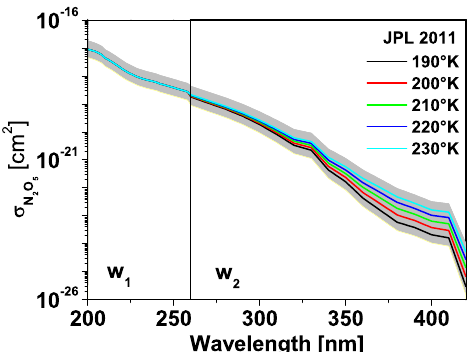
(λ,T ) Figure 2. Absorption cross section and uncertainty of σ N 2 O 5 as recommended by JPL 2011 (Sander et al., 2011) (grey area). For Fig. 2. Absorption cross-section and uncertainty of σ N 2 O 5 ( λ,T ) as recommended by JPL 2011 (Sander et al., 2011) (grey area). For this (λ,T ) is divided into two wavelength regions, w 1 this study, σ N study, σ N 2 O 5 ( λ,T ) is divided into two wavelength regions w 1 and w 2 . No temperature dependence of σ N 2 O 5 ( λ,T ) is reported for w 1 , the 2 O 5 (λ,T ) is reported for and w 2 . No temperature dependence of σ N T dependence for w 2 is indicated by different colours. 2 O 5 Figure 1. Temporal evolution of N 2 O 5 (red), HNO 3 (green) and w 1 , the T dependence for w 2 is indicated by different the sum of other NO y species (ClONO 2 + HO 2 NO 2 + BrONO 2 , Fig. 1. Temporal evolution of N 2 O 5 (red), HNO 3 (green) and the sum of other NO y species ( ClONO 2 + HO 2 NO 2 + BrONO 2 , blue) for blue) for different altitudes of the tropical mid-stratosphere (5.1 ◦ S, different altitudes of the tropical mid-stratosphere (5.1 ◦ S, 43.6 ◦ W). The lower boundary of the striped area denotes the temporal evolution 43.6 ◦ W). The lower boundary of the striped area denotes the tem- of the particular gas, and the striped area shows the total amount of NO x , which is released by photolysis from the considered NO y species. poral evolution of the particular gas, and the striped area shows the Note that the release from N 2 O 5 is double due to two N atoms. total amount of NO x , which is released by photolysis from the con- sidered NO y species. Note that the release from N 2 O 5 is double due to two N atoms.